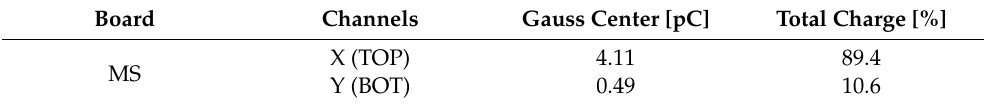
Table 3. Charge distribution between the top and bottom electrodes of the ceramic readout